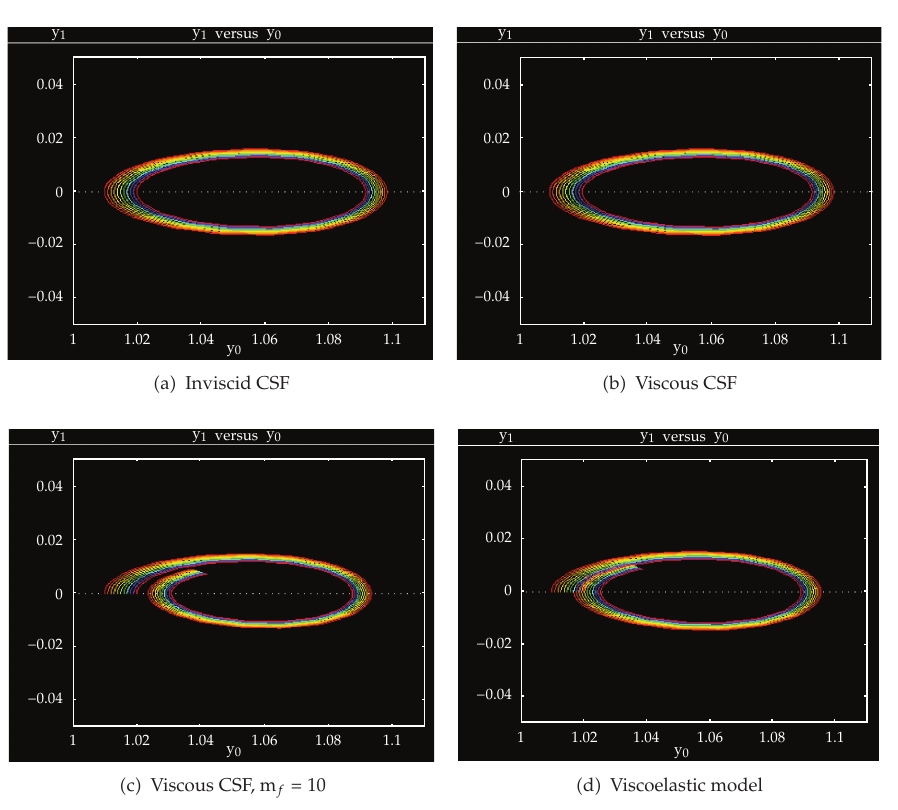
Figure 3: Phase portraits for inviscid CSF, viscous CSF, and viscoelastic